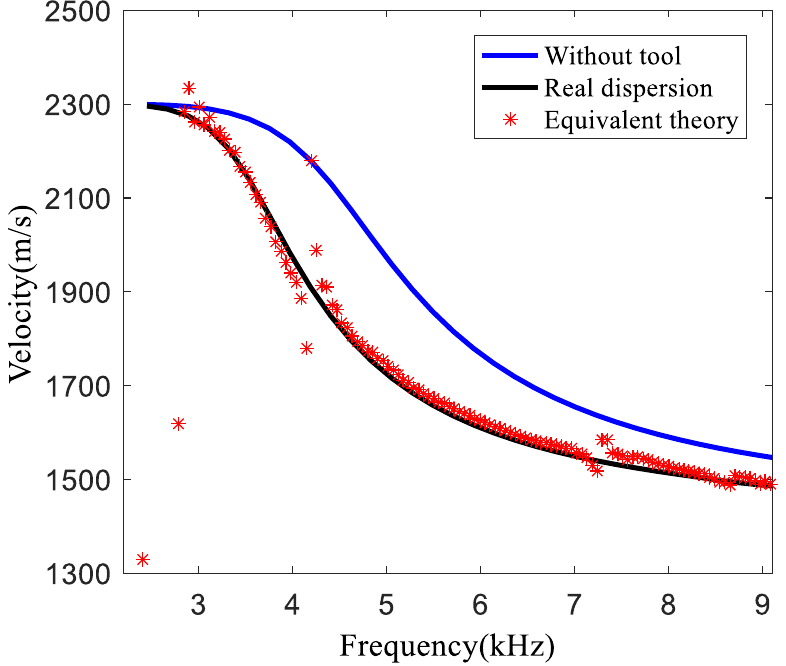
Figure 7. Dispersion curve without tool impacts (blue); reference dispersion curve calculated by the equivalent-tool theory (black); dispersion curves of the waveform affected by the tool (red).